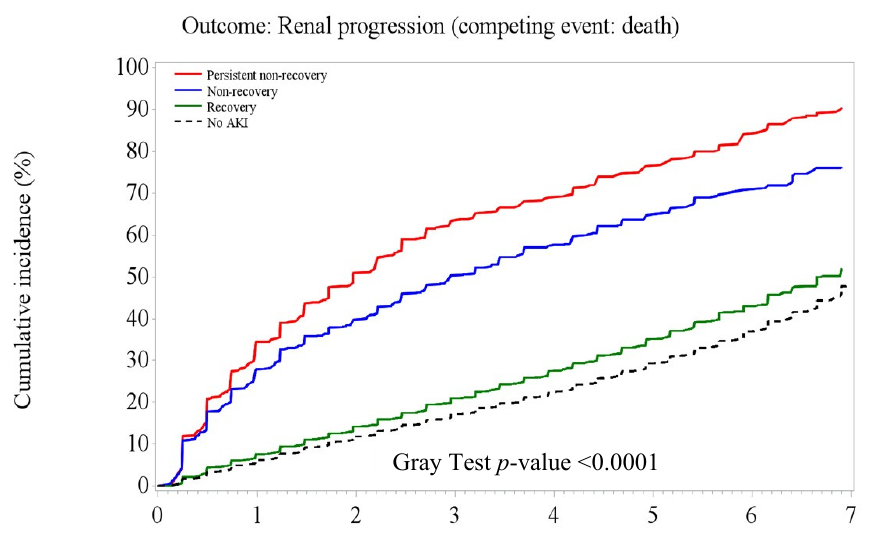
Gray Test p -value <0.0001